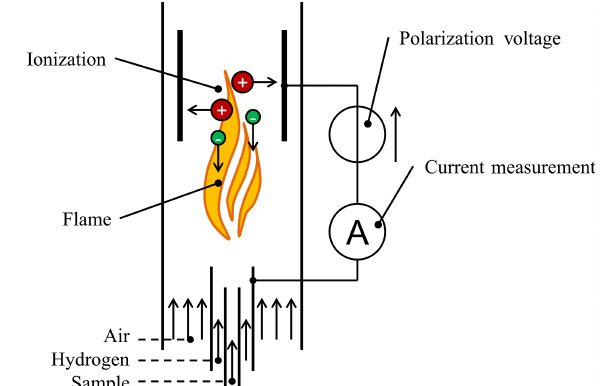
Figure 1. Schematic drawing of an FID.